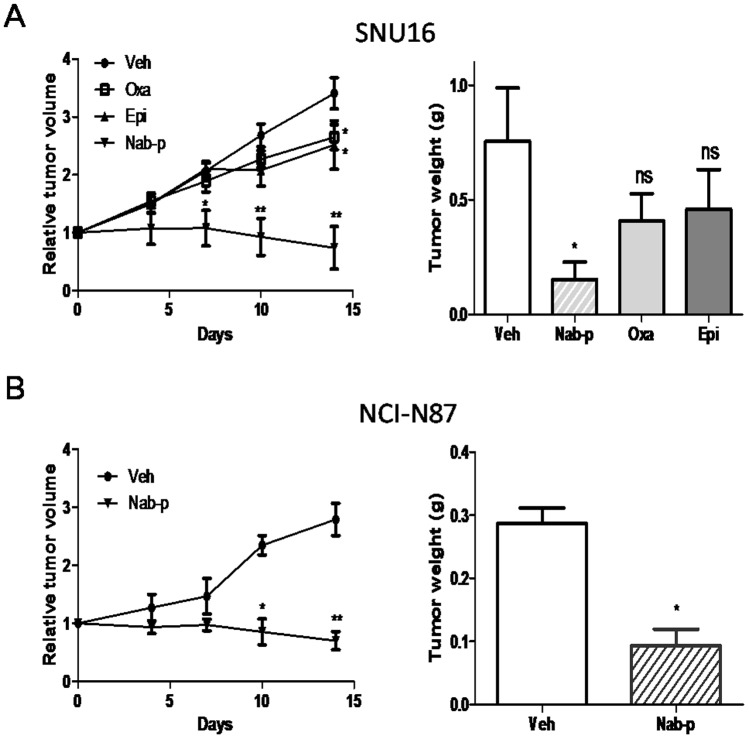
Nab-paclitaxel inhibits growth of established local tumor.(A) SCID mice were subcutaneously injected with SNU16 cells (20×106) and treated with nab-paclitaxel, oxaliplatin and epirubicin for 2 weeks. (B) SCID mice were subcutaneously injected with NCI-N87 cells (10×106) and treated with nab-paclitaxel for 2 weeks. Relative tumor volume and tumor weight on the final day were assessed. Data are representative of mean values ± standard deviation from 6–8 mice per group. Symbol * represents significant difference (p<0.05) and symbol ** represents significant differences (p<0.001) compared to vehicle controls; ns  =  no significant difference.